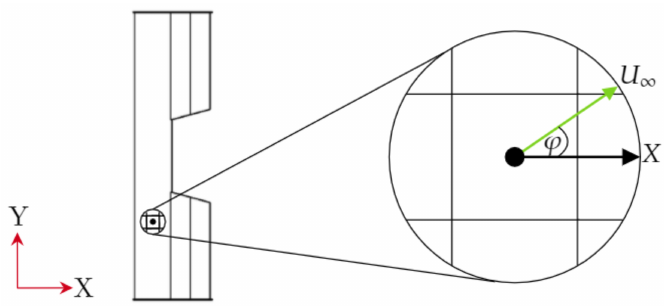
Figure 12. A schematic diagram defining the yaw angle of a particular